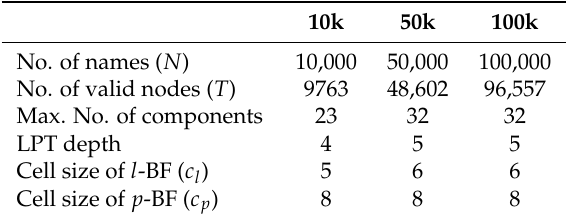
Table 1. Routing set characteristics and Bloom filter cell sizes.